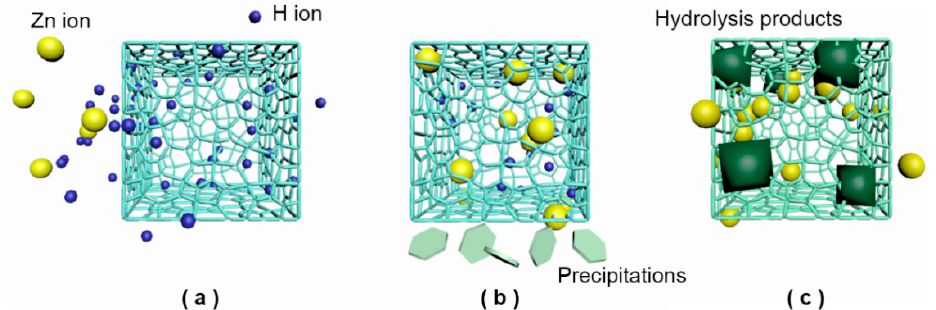
Figure 8. The leaching mechanism of the process: at the adsorption beginning stage: ( a ) The porous green cubic matrix of zeolite A were surrounded with yellow spheres Zn 2+ ions, blue spheres the H + ions. In the pH value elevation stage ( b ), the precipitates formed as green hexagonal plates. After the hydrolysis happened in stage ( c ), dark green cubic material was the hydrolysis complex formed at the surface of the pale blue matrix of the zeolite.